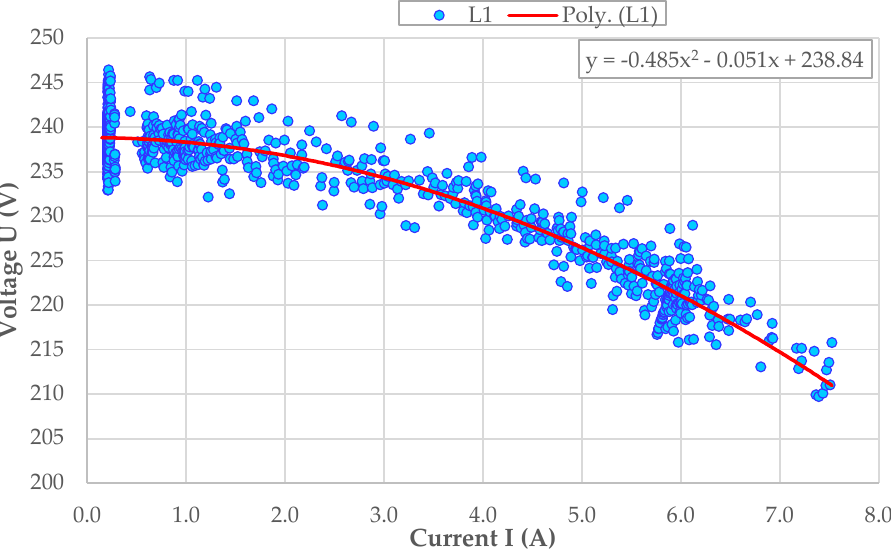
Figure 13. Phase L1 voltage–current curve with polynomial function describing the voltage drop dependency from the capacity of the load based on measurements in Object 2.